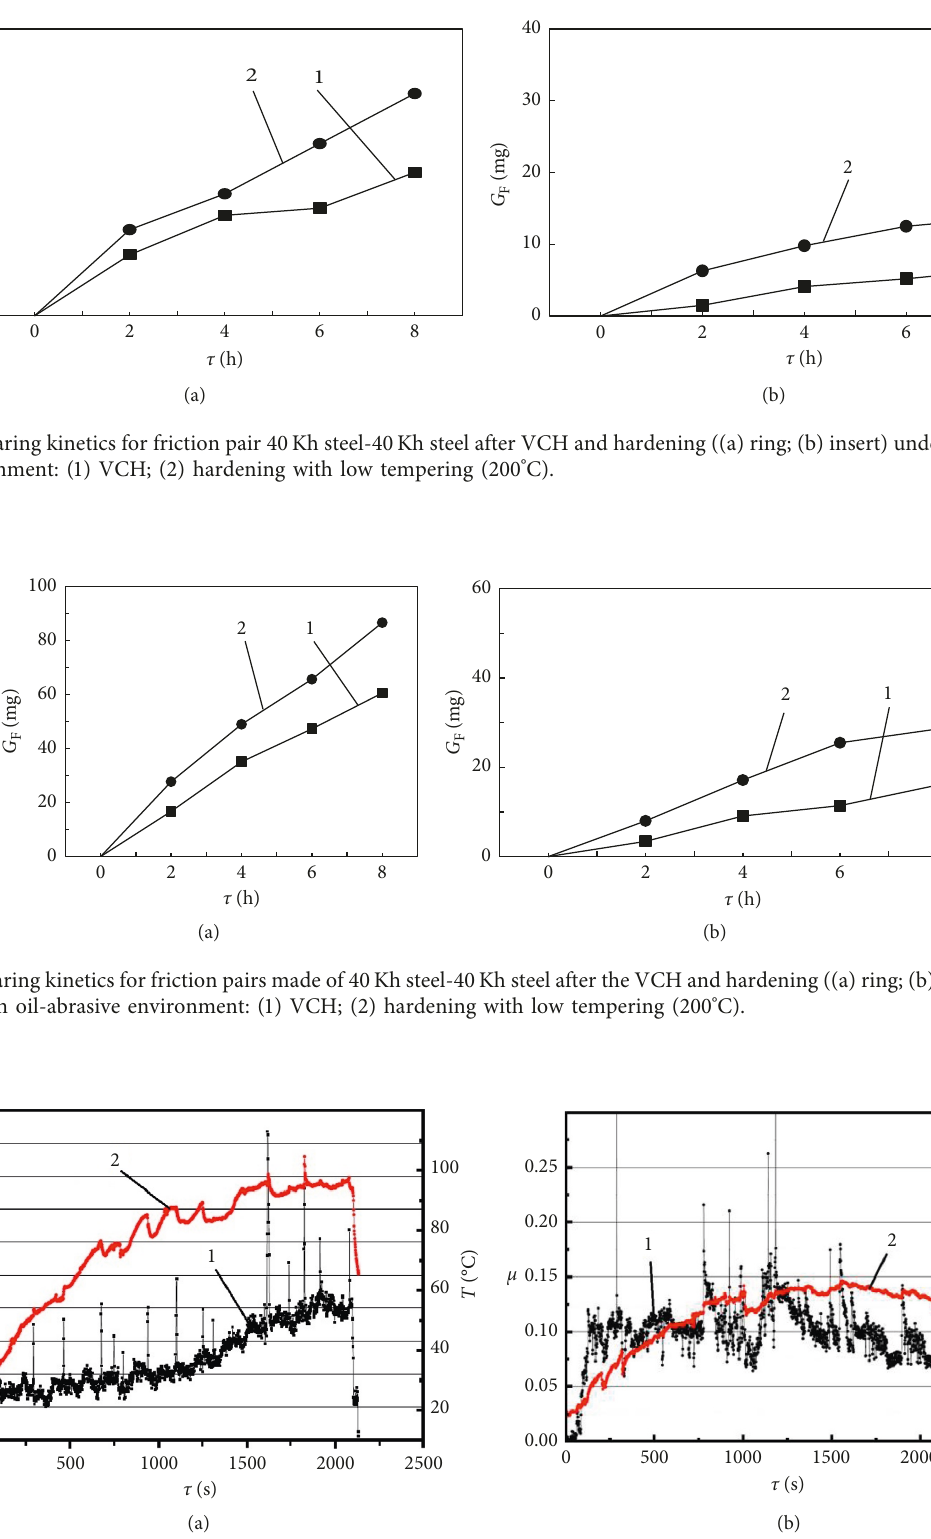
Figure 8: Friction coefficient (1) and temperature (2) for pairs made of steels 40Kh-40Kh after hardening ring (a) and the processed VCH (b).